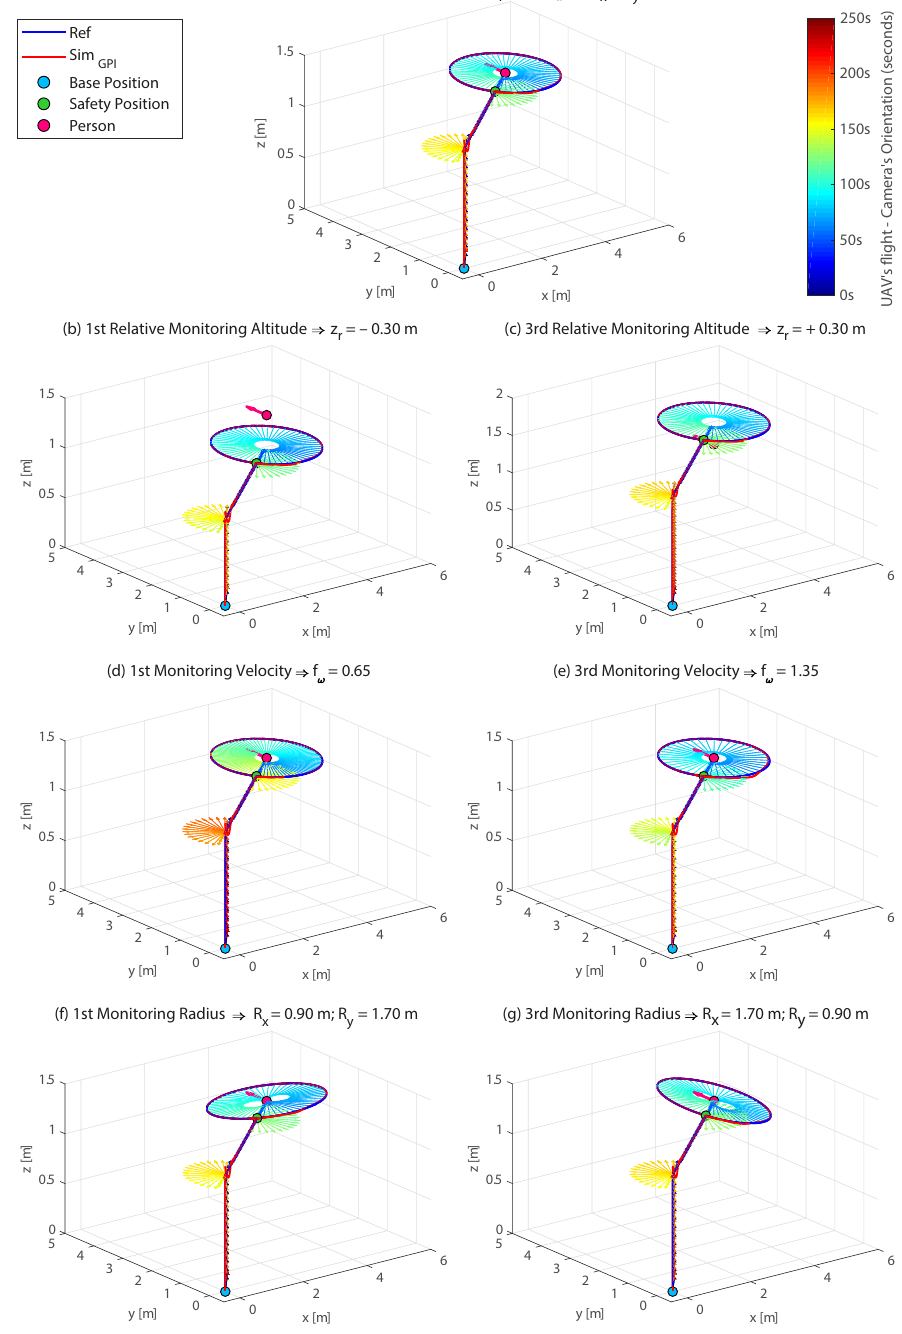
Figure 7. Results of the tests to verify the new ellipsoidal trajectory planner carried out using the UAV simulator (part of the VR platform and implemented in MATLAB/Simulink ® ). For each test, the following is represented: (1) trajectory generated by the planner (in blue) against the actual trajectory performed by the quadrotor model as the result of the action of the GPI controller (in red); (2) orientation of the UAV’s camera by means of arrows whose colour change over time; (3) way- points: base position (blue circle), safety position (green circle), and person’s position and orientation (pink circle and